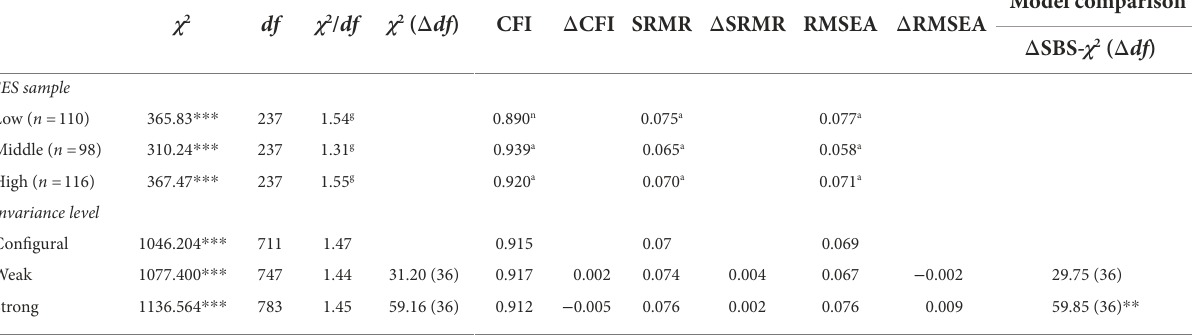
TABLE 5 Confirmatory factor analyzes for socioeconomic status (SES) subsamples and invariance